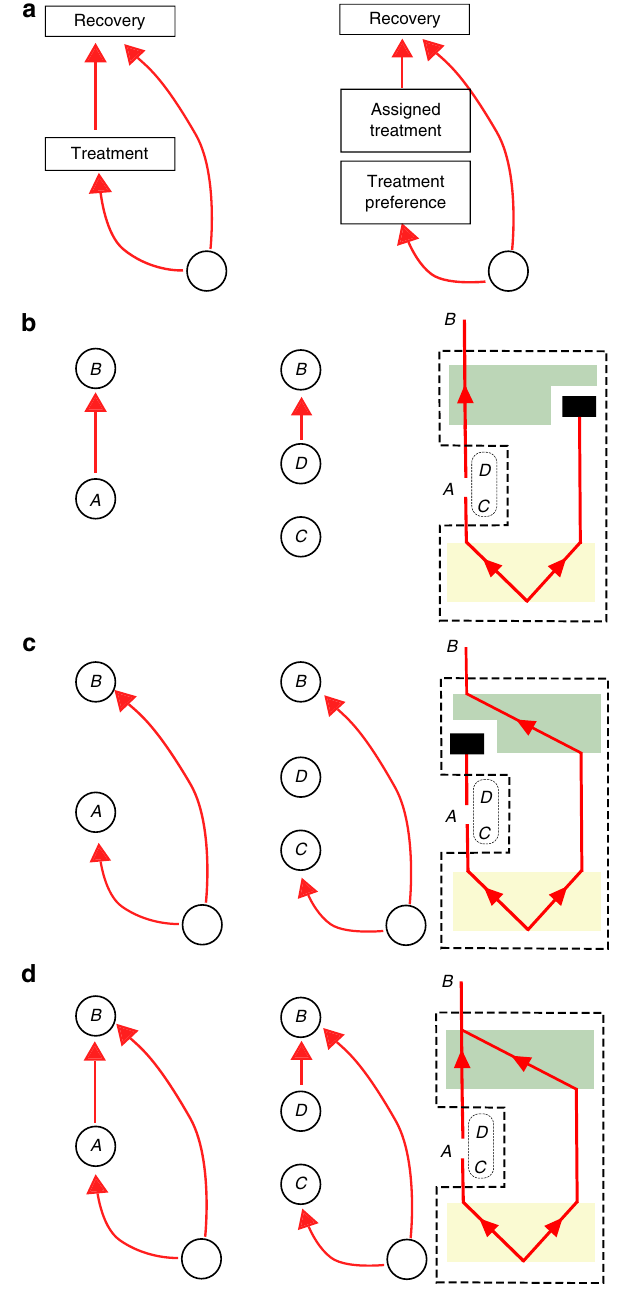
Figure 2 | Causal relations between two time-ordered